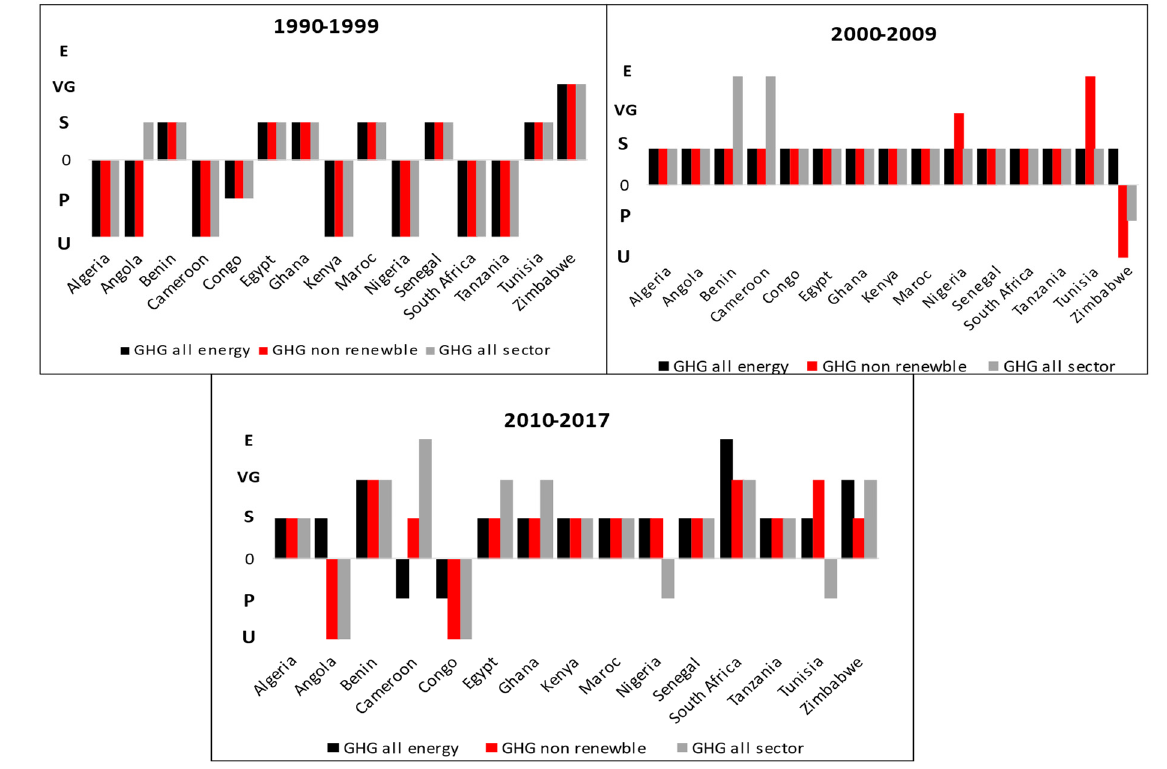
Figure 7. WEF’s GHG footprint–total Energy’s GHG footprint.